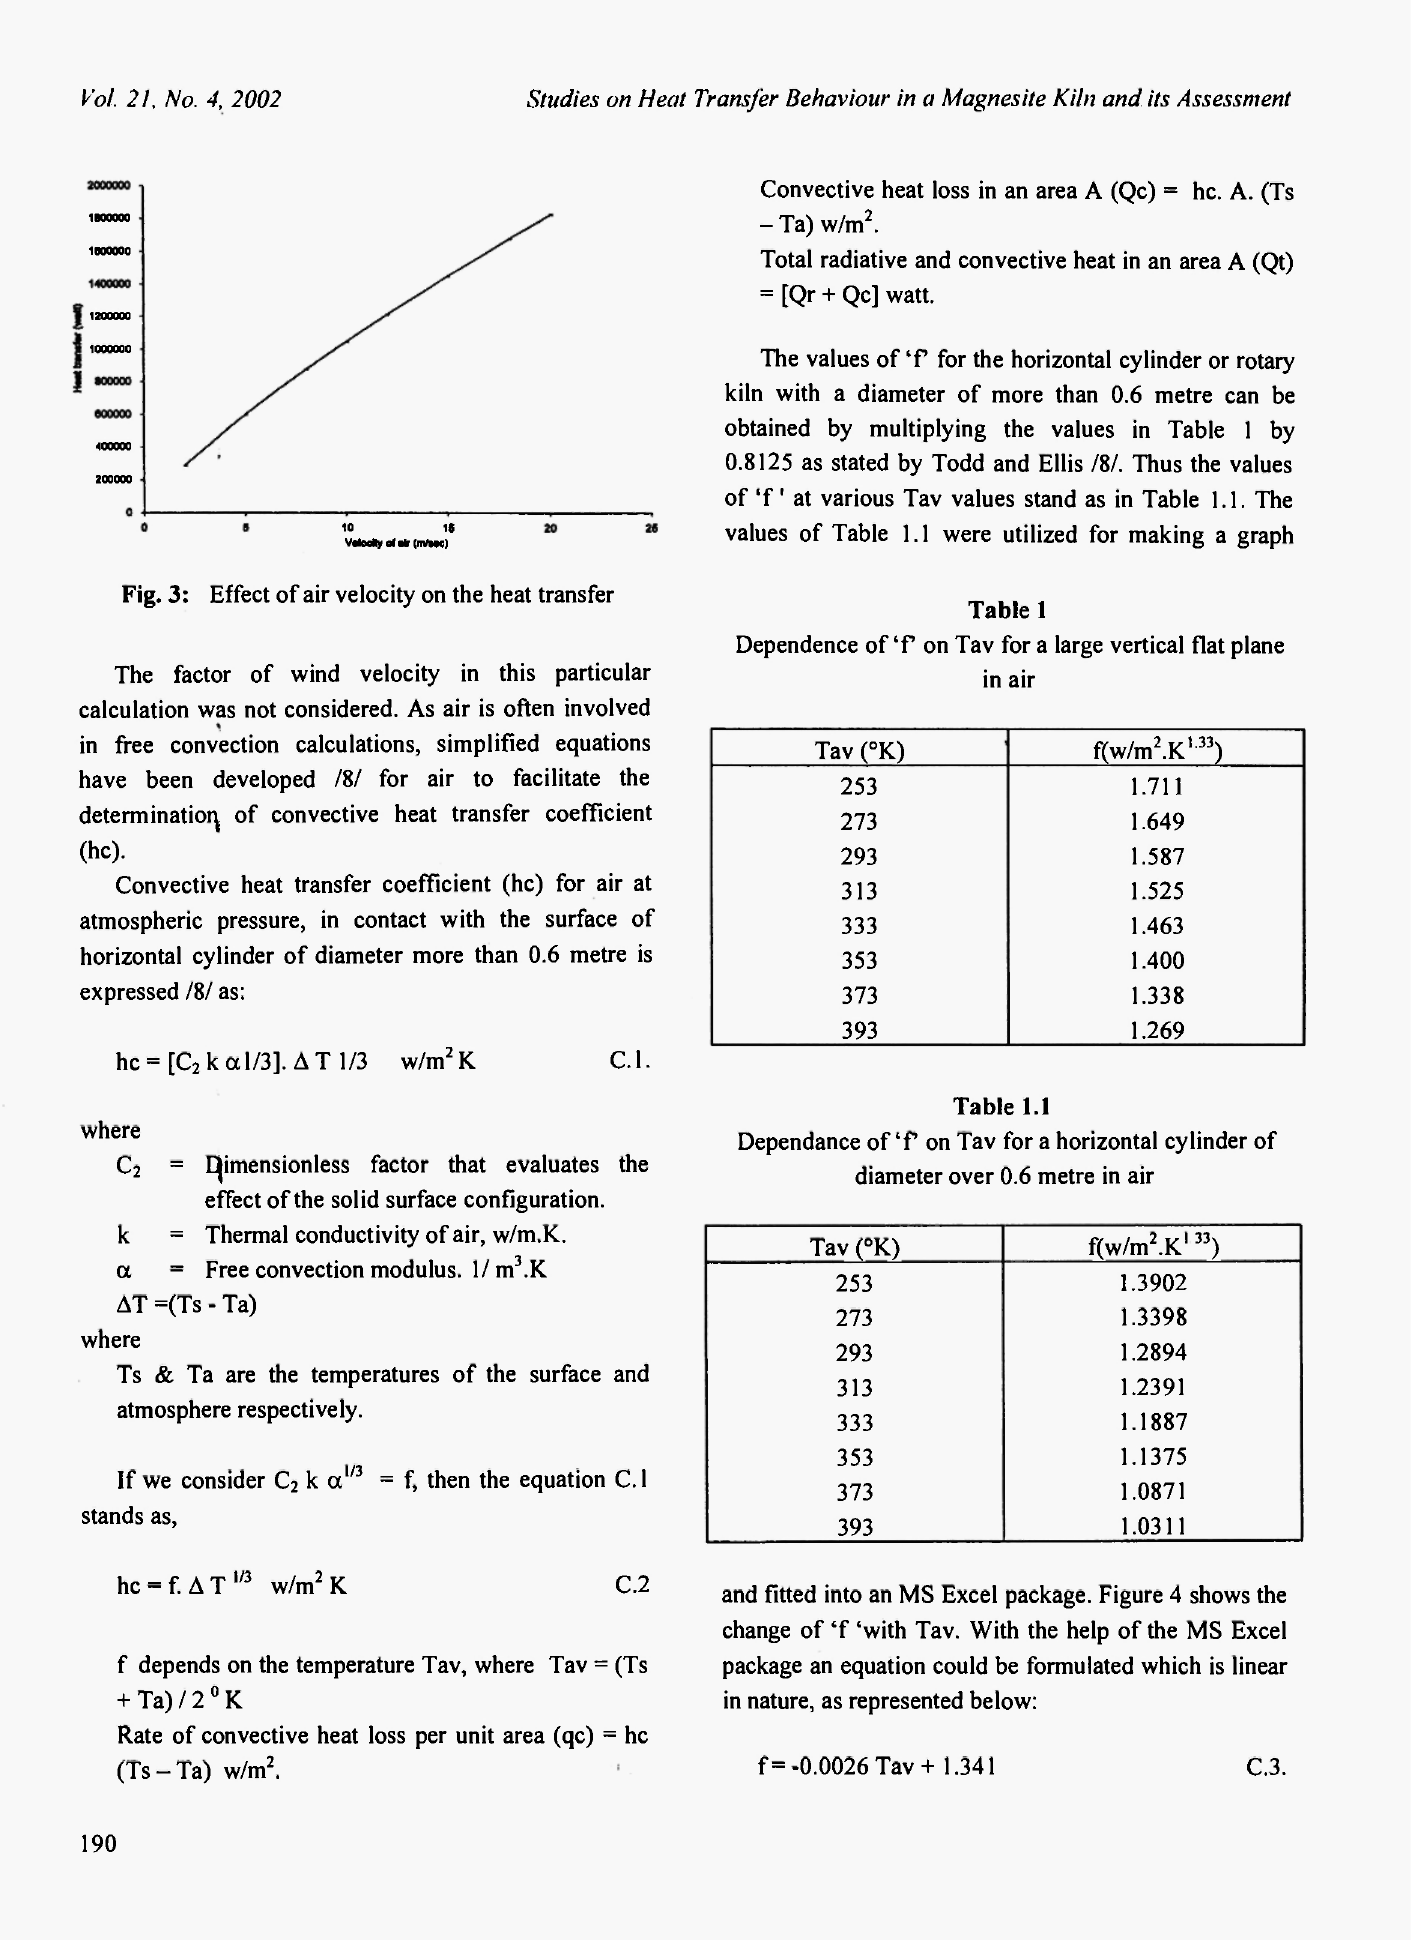
Dependance o f 'f on Tav for a horizontal cylinder of diameter over 0.6 metre in